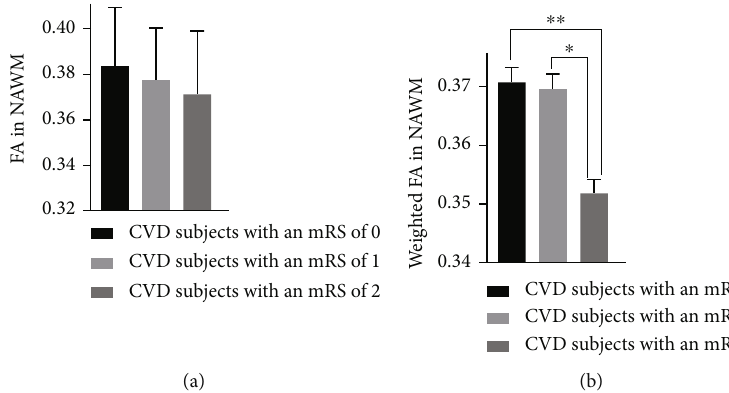
Figure 7: FA in NAWM in CVD subjects with various mRS scores (0, 1, and 2) (a) and FA in NAWM weighted by the normalized WMH volumes in CVD subjects with di ff erent mRS scores (0, 1, and 2) (b). The bars and error bars in panel (a) represent the mean and standard deviation of FA in NAWM. The bars and error bars in panel (b) represent the weighted mean and weighted standard deviation of FA in NAWM following statistical weighting by the normalized WMH volumes. Data with asterisk and double asterisk were signi fi cantly di ff erent as detected by pairwise comparison following the ANCOVA test with p value < 0.002 and p value < 0.001,